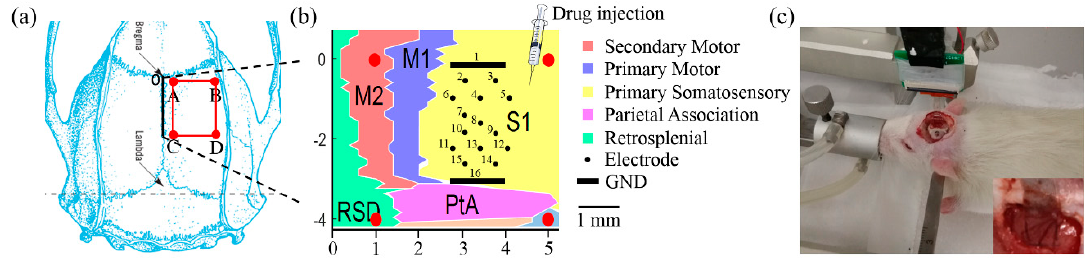
Figure 2. The placement of the ECoG electrode array for neural activities recording. ( a ) Cortical craniotomy location was performed in the red frame; ( b ) Location of electrode sites attached to subdural primary somatosensory cortex of rats. The drug was injected on the primary somatosensory cortex, adjacent to the ECoG electrode array; ( c ) The ECoG electrode array was attached to the cortex of anesthetized rats.